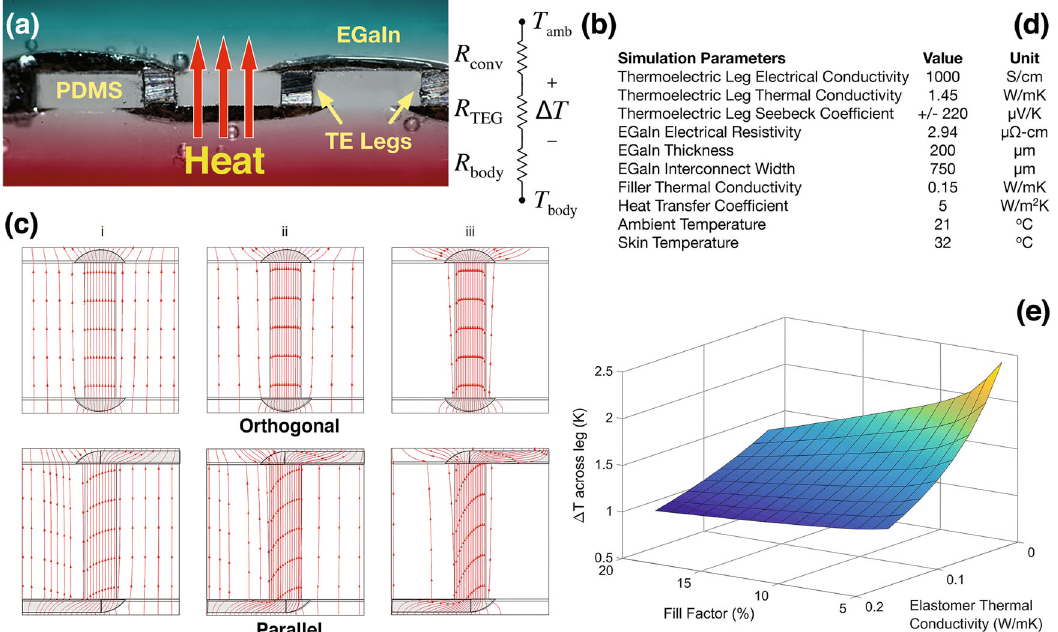
Fig. 1 Heat leakage through the fl exible fi ller and its impact on the temperature differential across the thermoelectric legs. a Cross- sectional microscope image of a fl exible TEG with liquid metal interconnects. b A simple three-resistor thermal equivalent circuit of a TEG. c Cross-sections parallel and orthogonal to the interconnects illustrating simulated heat fl ow lines through the thermoelectric legs and the surrounding elastomer with three different thermal conductivities of (i) 0.15, (ii) 0.08, and (iii) 0.025 Wm − 1 K − 1 . d Simulated temperature differential plotted as a function of module fi ll factor and elastomer thermal